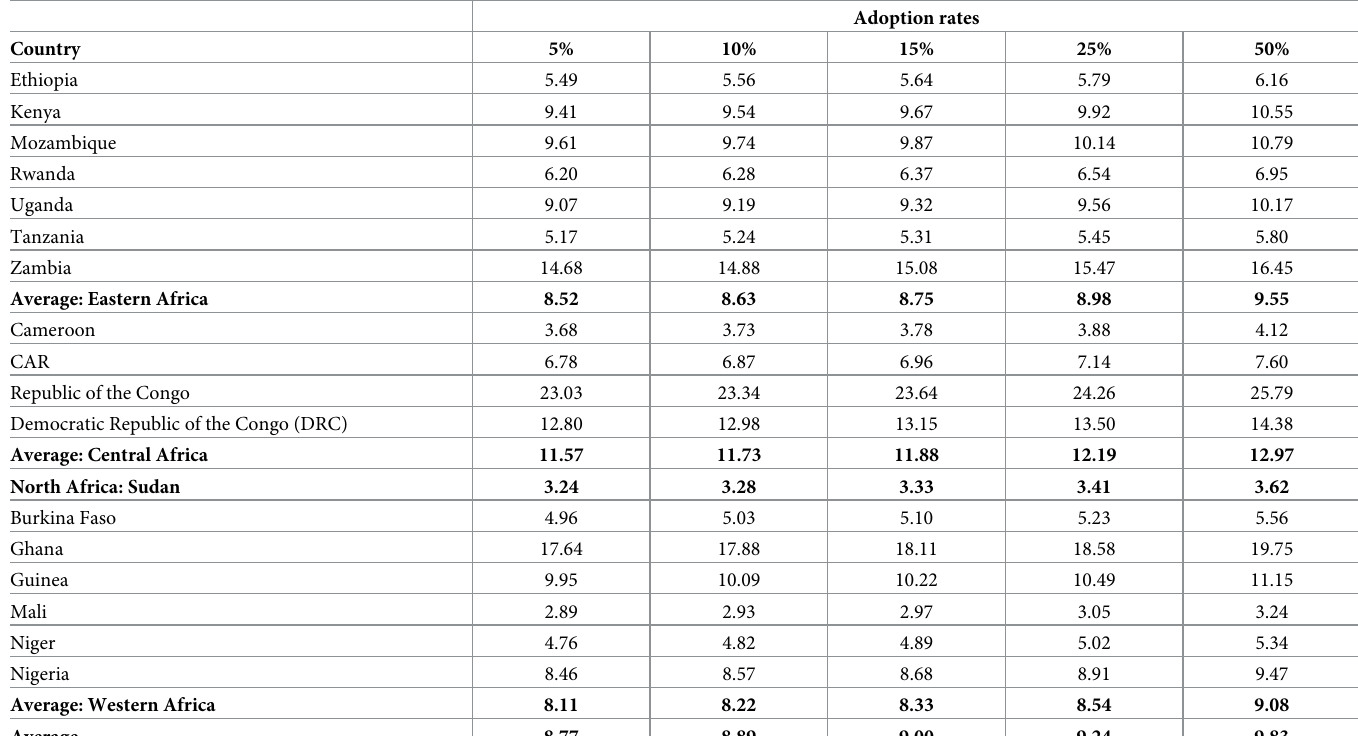
Table 4. Estimated benefit-cost ratio